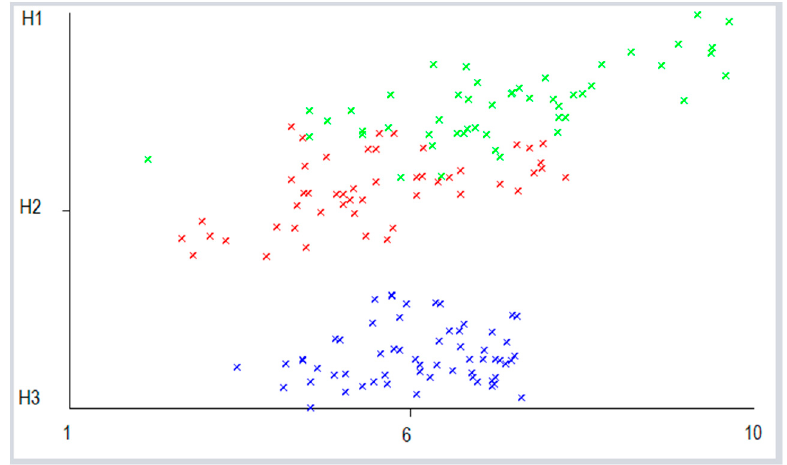
Figure 6. Results obtained by improving the evaluation execution times. H1: Forums, H2: Homework, H3: Evaluations.